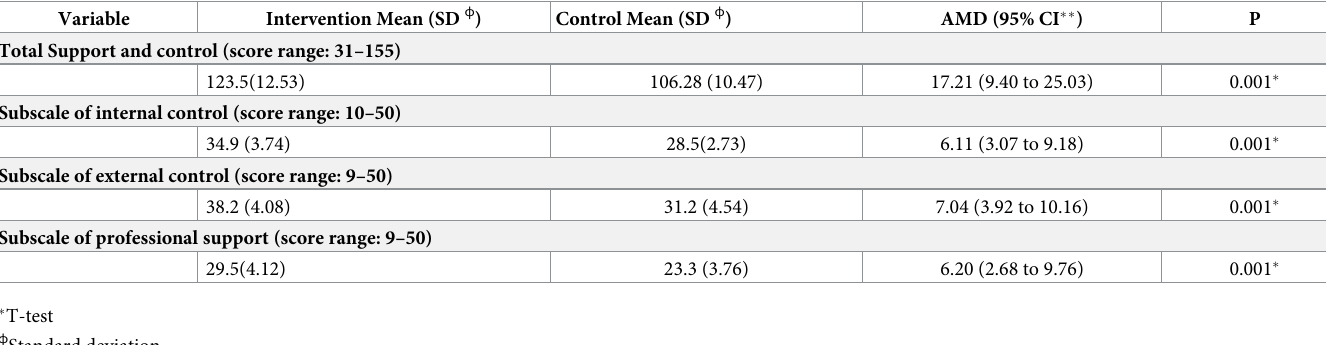
Table 4. The comparison of mean score of control and support during childbirth in the intervention and control groups after the intervention.